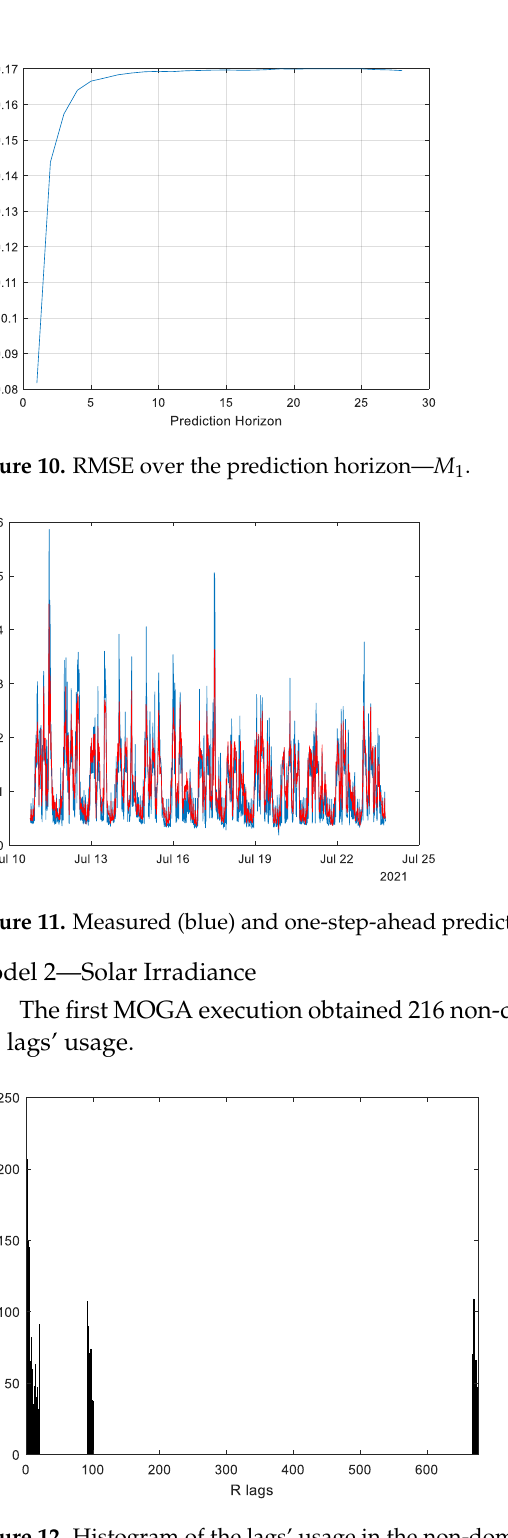
Figure 12. Histogram of the lags ’ usage in the non-dominated M 2